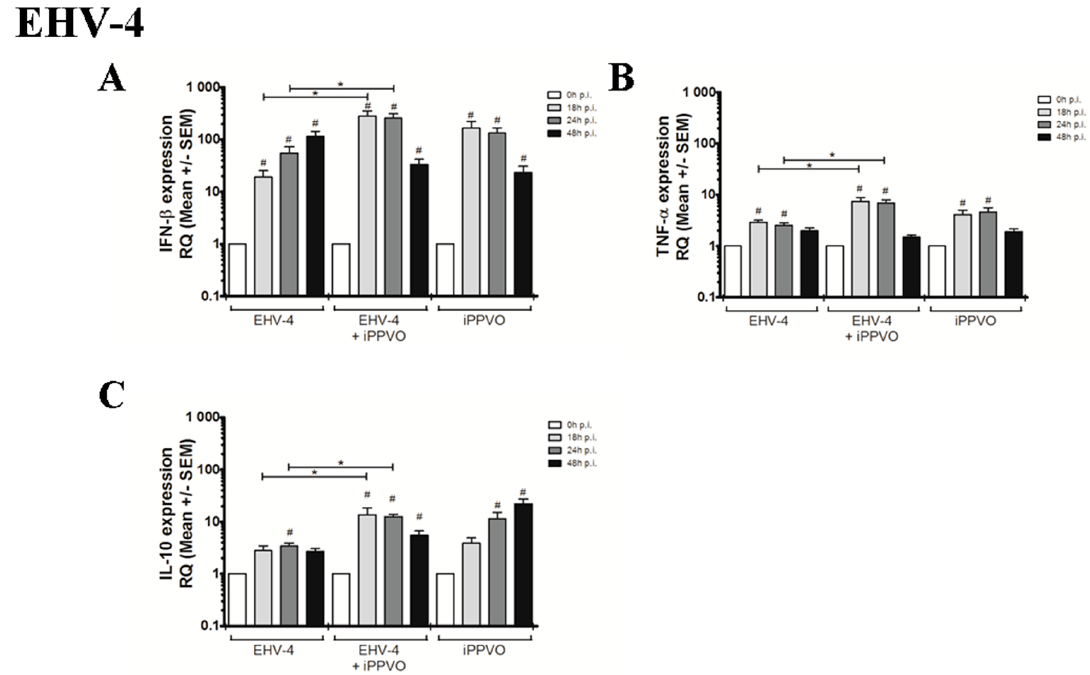
Figure 3. Cytokine mRNA expression measured by real-time PCR after infection of PBMC with EHV-4 alone, after co-treatment iPPVO/EHV-4 and after iPPVO treatment. Cytokines measured were IFN- β ( A ), TNF- α ( B ), and IL-10 ( C ). White bars represent mRNA expression at 0 h (T 0 ), light grey bars represented mRNA expression at 18 hpi, dark grey bars at 24 hpi, and black bars at 48 hpi; n = 3 horses with 3 independent reverse-transcriptase PCR. Data are reported as means ± SEM as fold increase over the T 0 . The level of significance was set as p -value < 0.05. Significant differences compared to T 0 are indicated by # and differences between all conditions by star ( p < 0.05). The iPPVO/EHV co-infection condition was compared with EHV infection alone or iPPVO treatment alone.